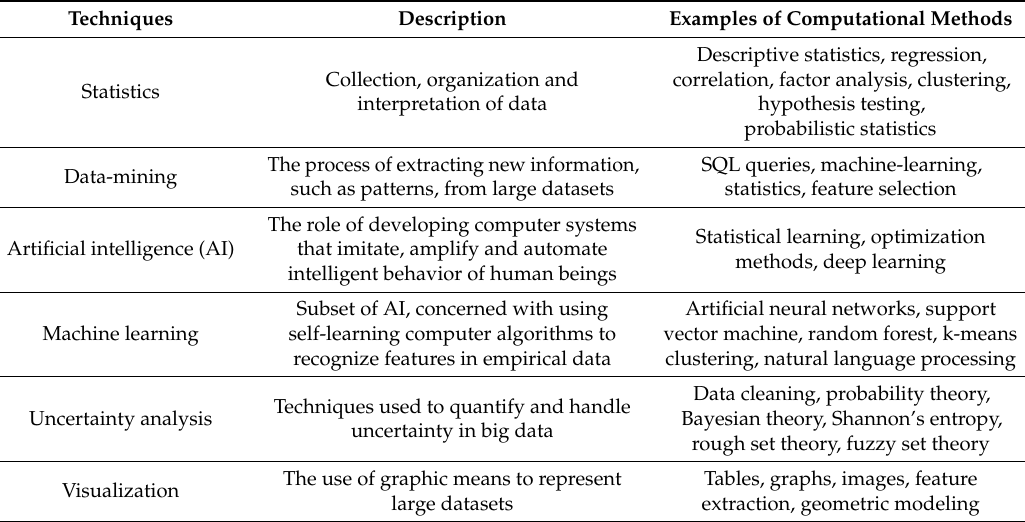
Table 4. Summary of big data analytical techniques